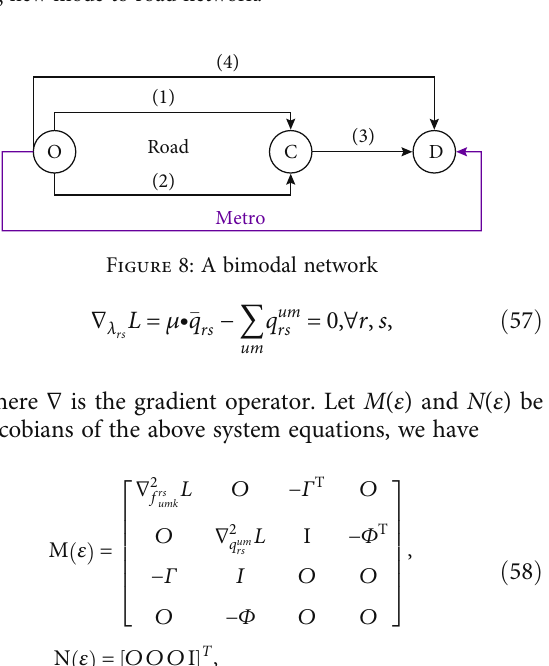
Figure 7: E ff ect on network capacity of adding new mode to road